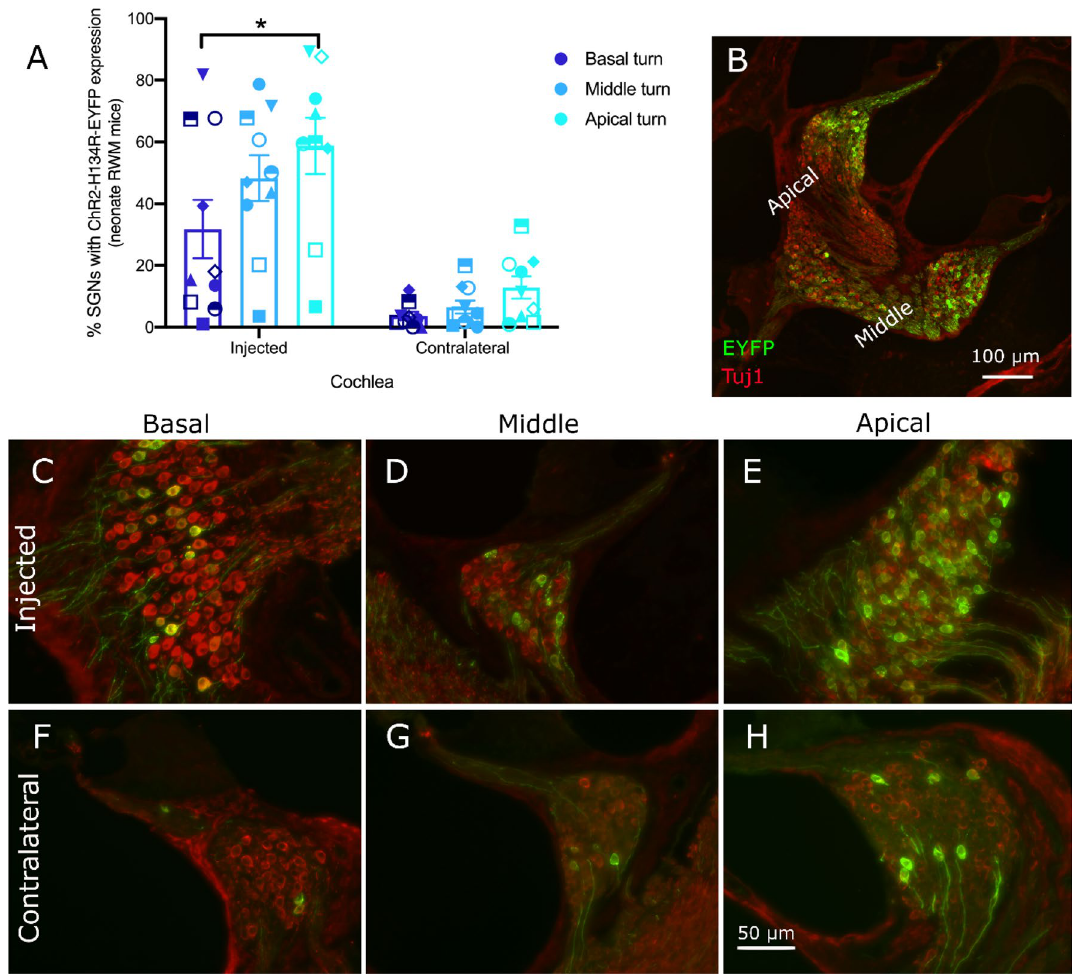
Figure 2. ChR2-H134R-EYFP expression in cochlear SGNs following RWM AAV injection in neonatal C57BL/6 mice. ( A ) The average percentage of EYFP-expressing SGNs was significantly different between each turn (p < 0.05; *p < 0.001 between base and apex; RM ANOVA; n = 10). A similar transduction pattern was observed on the contralateral side, but with overall lower transduction (error bars show the standard error of the mean; one mouse with no ChR2-H134R-EYFP expression was excluded in order to show average expression in successfully transduced mice). ( B ) Section of an injected cochlea showing the middle and apical turns. Transduced cells were visualised via the EYFP reporter (green) and the neurons were counterstained with the Tuj1 antibody (red). Expression of ChR2-H134R-EYFP was observed in SGN cell bodies and their central and peripheral fibres. ( C-E ) Images of Rosenthal’s canal from the basal, middle and apical turns of RWM-injected neonatal mice. The proportion of SGNs expressing ChR2-H134R-EYFP increased in a basal to apical direction. ( F–H ) Contralateral side Rosenthal’s canal images from the basal, middle and apical turns. Scale bar in H applies to images C to H. Minor image processing (brightness) was applied equally to the EYFP channel across C-H for representation